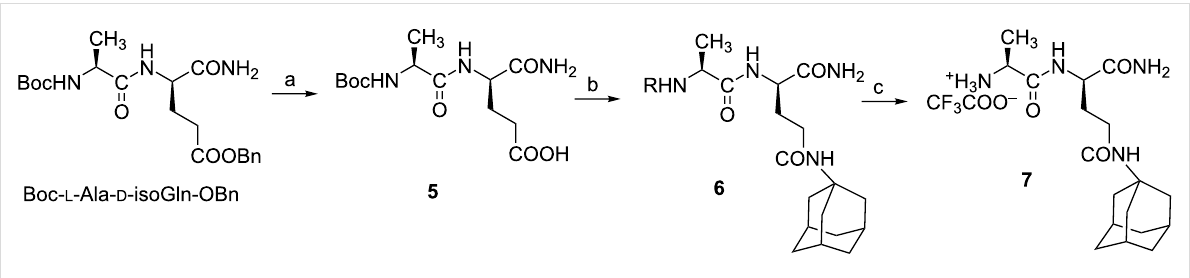
Scheme 2: Synthesis of C-modified desmuramyl peptides. Reagents and conditions: a) H 2 , 10% Pd/C, MeOH, 38 psi, rt, 24 h, 96%; b) adamant-1- ylamine hydrochloride, EDC·HCl, HOBt·H 2 O, Et 3 N, DCM/dioxane 1:1, 0 °C → rt, 48 h, 60%; c) TFA/DCM 1:2, rt, 1 h,